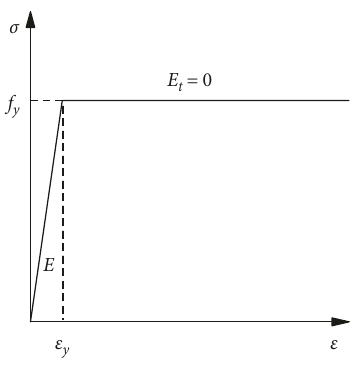
Figure 3: Bilinear constitutive model of steel. Table 1: Component specification